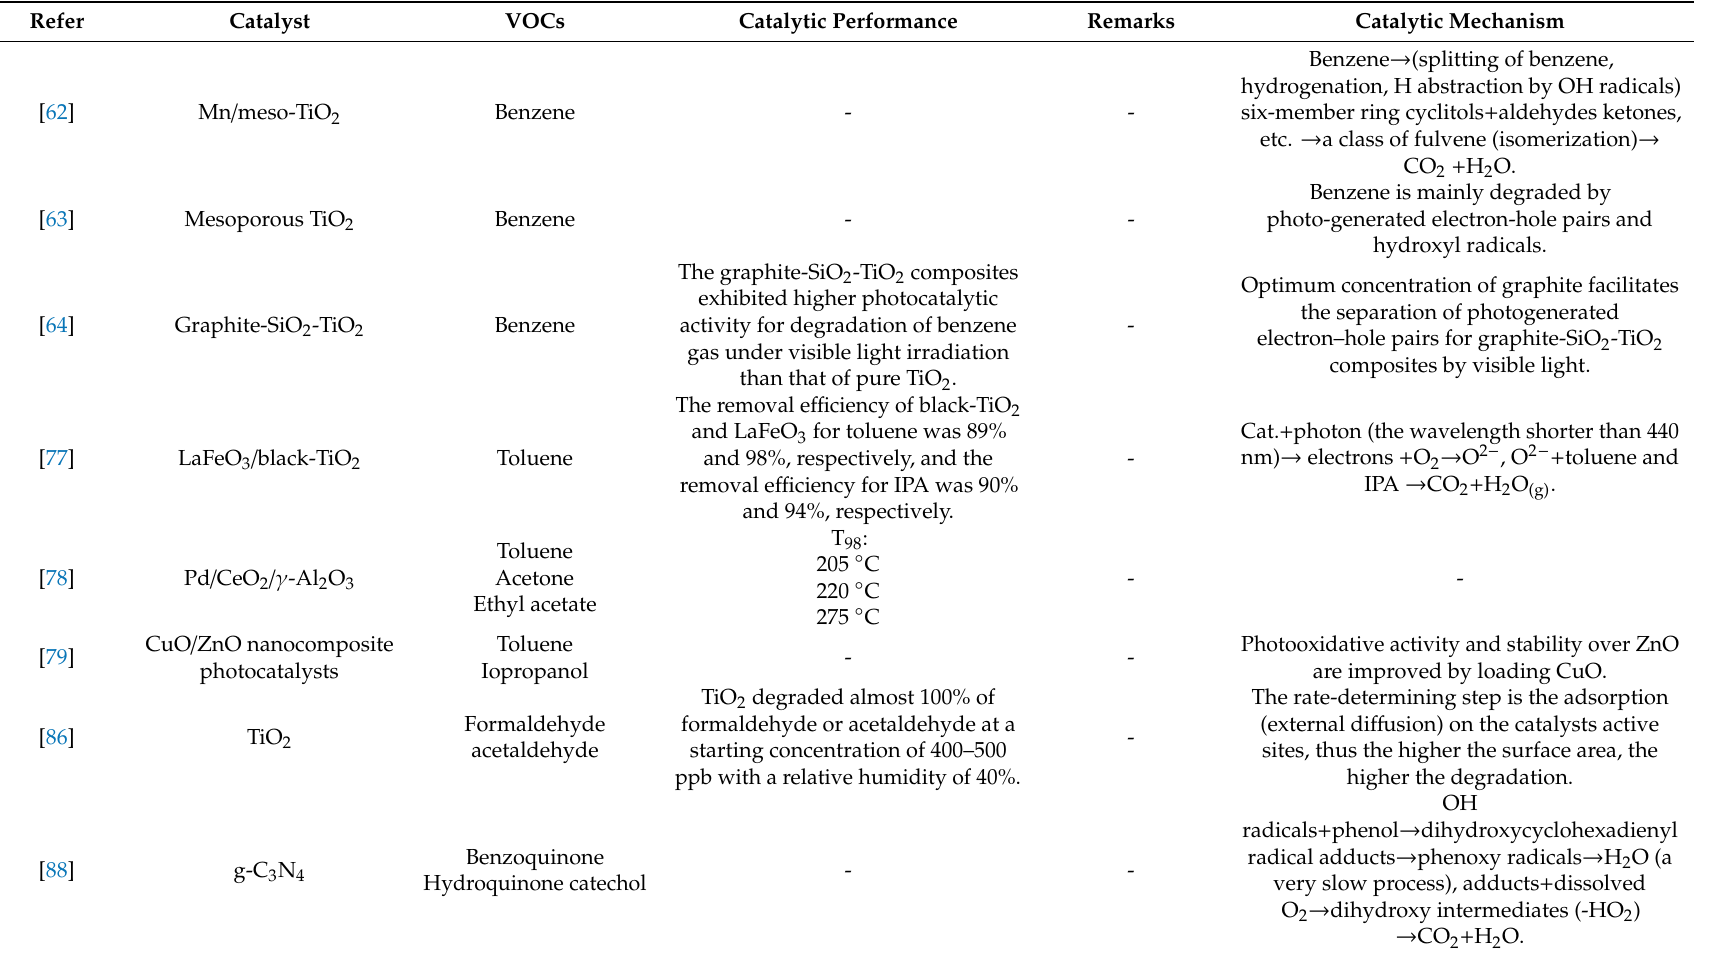
Table 9. Photocatalysts for elimination of